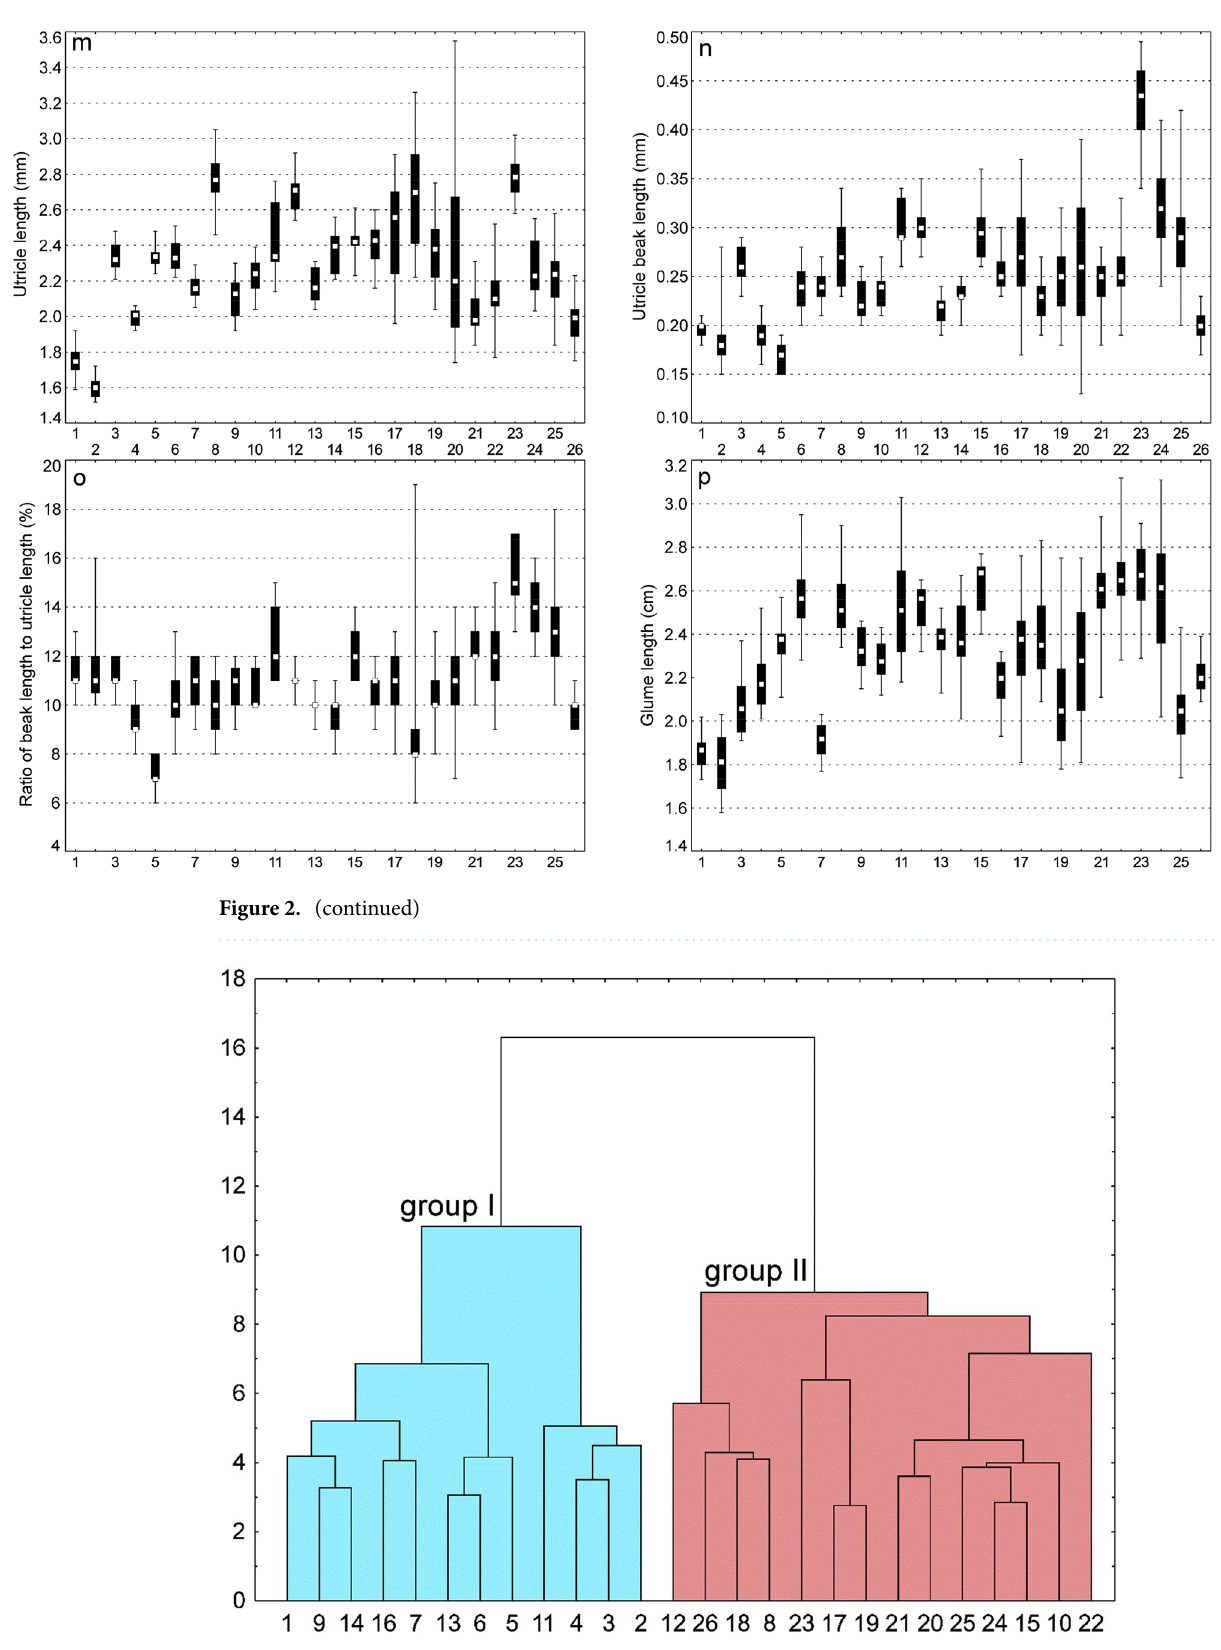
Figure 3. Results of Euclidean distance-based cluster analysis (Ward’s minimum variance) for Carex buekii populations. The populations are numbered as in Table